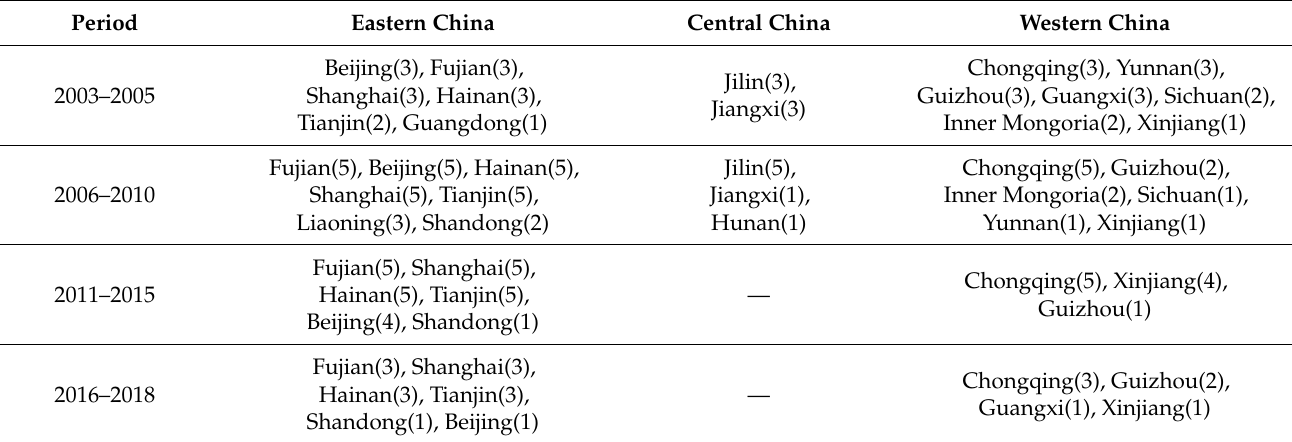
Table 4. Best provincial practitioners of eco-efficiency from 2003 to